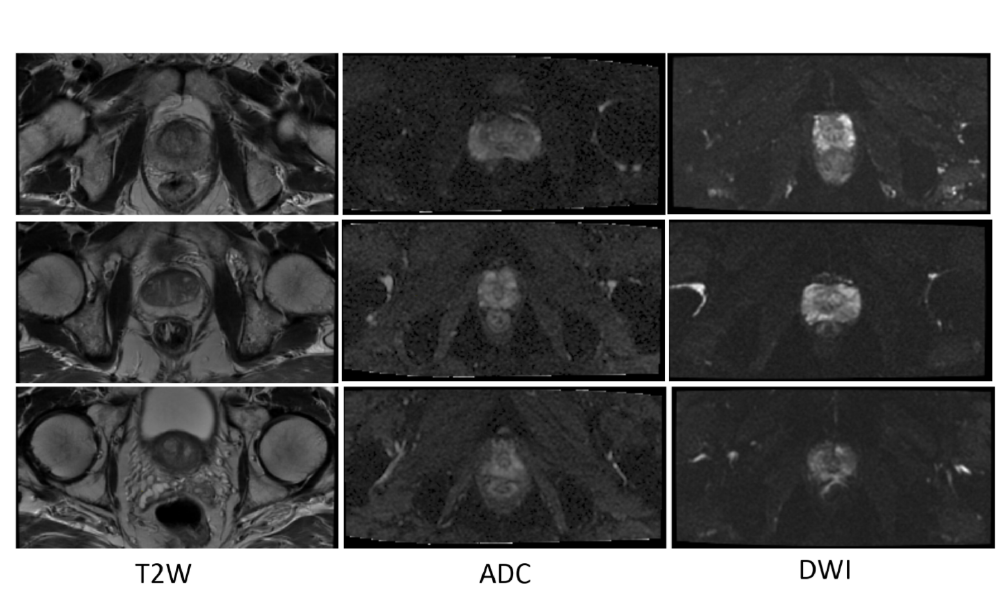
Figure 6. Some examples of T2W, ADC and DWI MR images from our dataset, which demonstrates that DWI and ADC modalities have lower signal around the prostate compared to the T2W modality. Scaled images are shown in Figure A2 for better